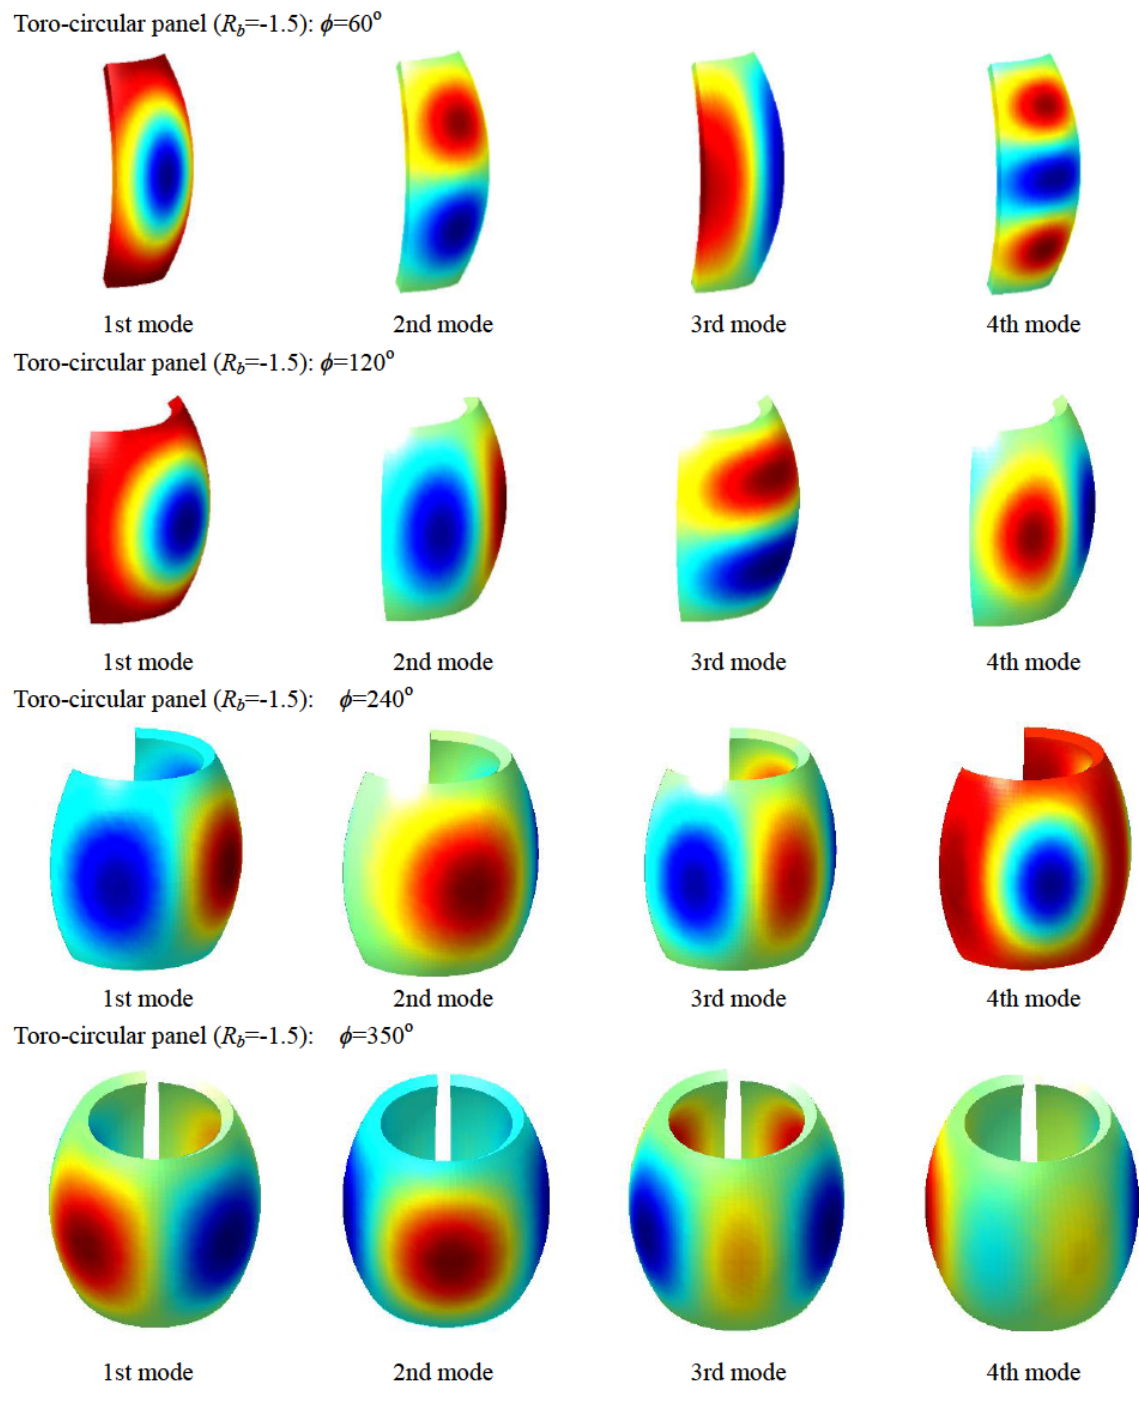
Figure 6: Mode shapes of the Toro-circular panel ( R b = − 1.5) with CE 1 CE 1 boundary condition.